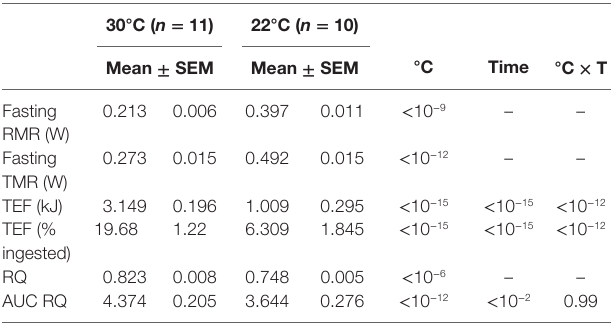
TaBle 1 | components of energy expenditure in fasted-refed